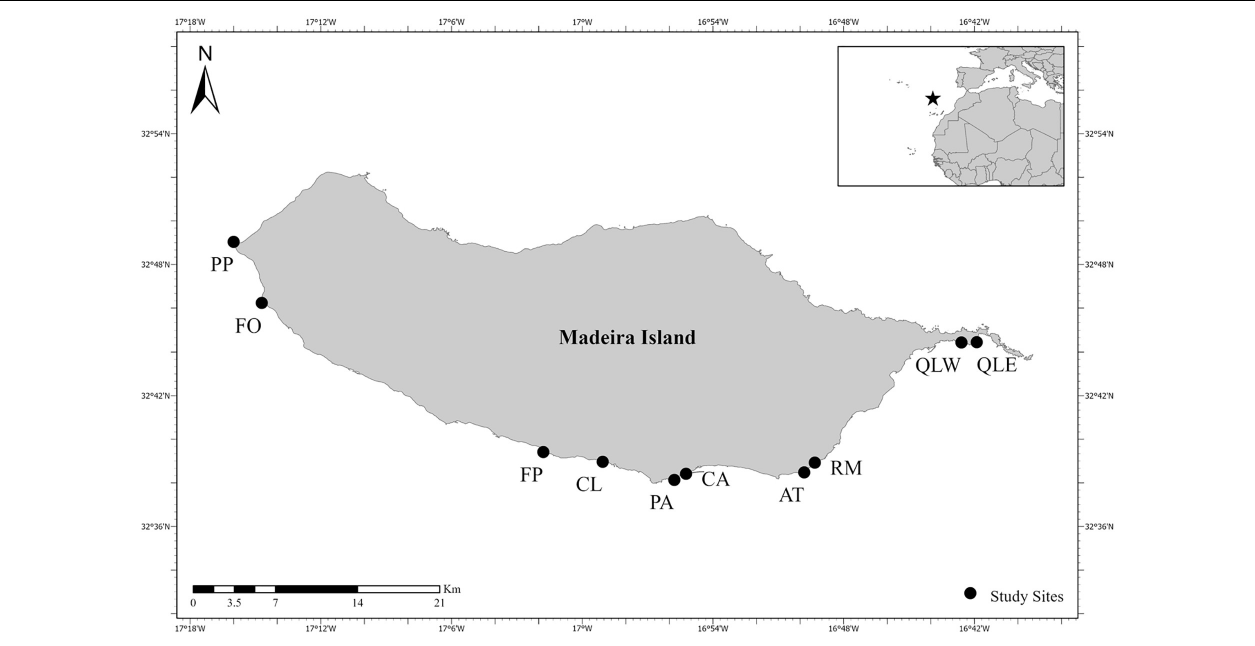
FIGURE 1 | Study area (Madeira Island, Portugal) and study sites represented by dots. PP, Ponta do Pargo; FO, Fajã da Ovelha; FP, Fajã dos Padres; CL, Câmara de Lobos; PA, Palms; CA, Carlton; AT, Atalaia; RM, Reis Magos; QLW, Quinta do Lorde West; QLE, Quinta do Lorde East.